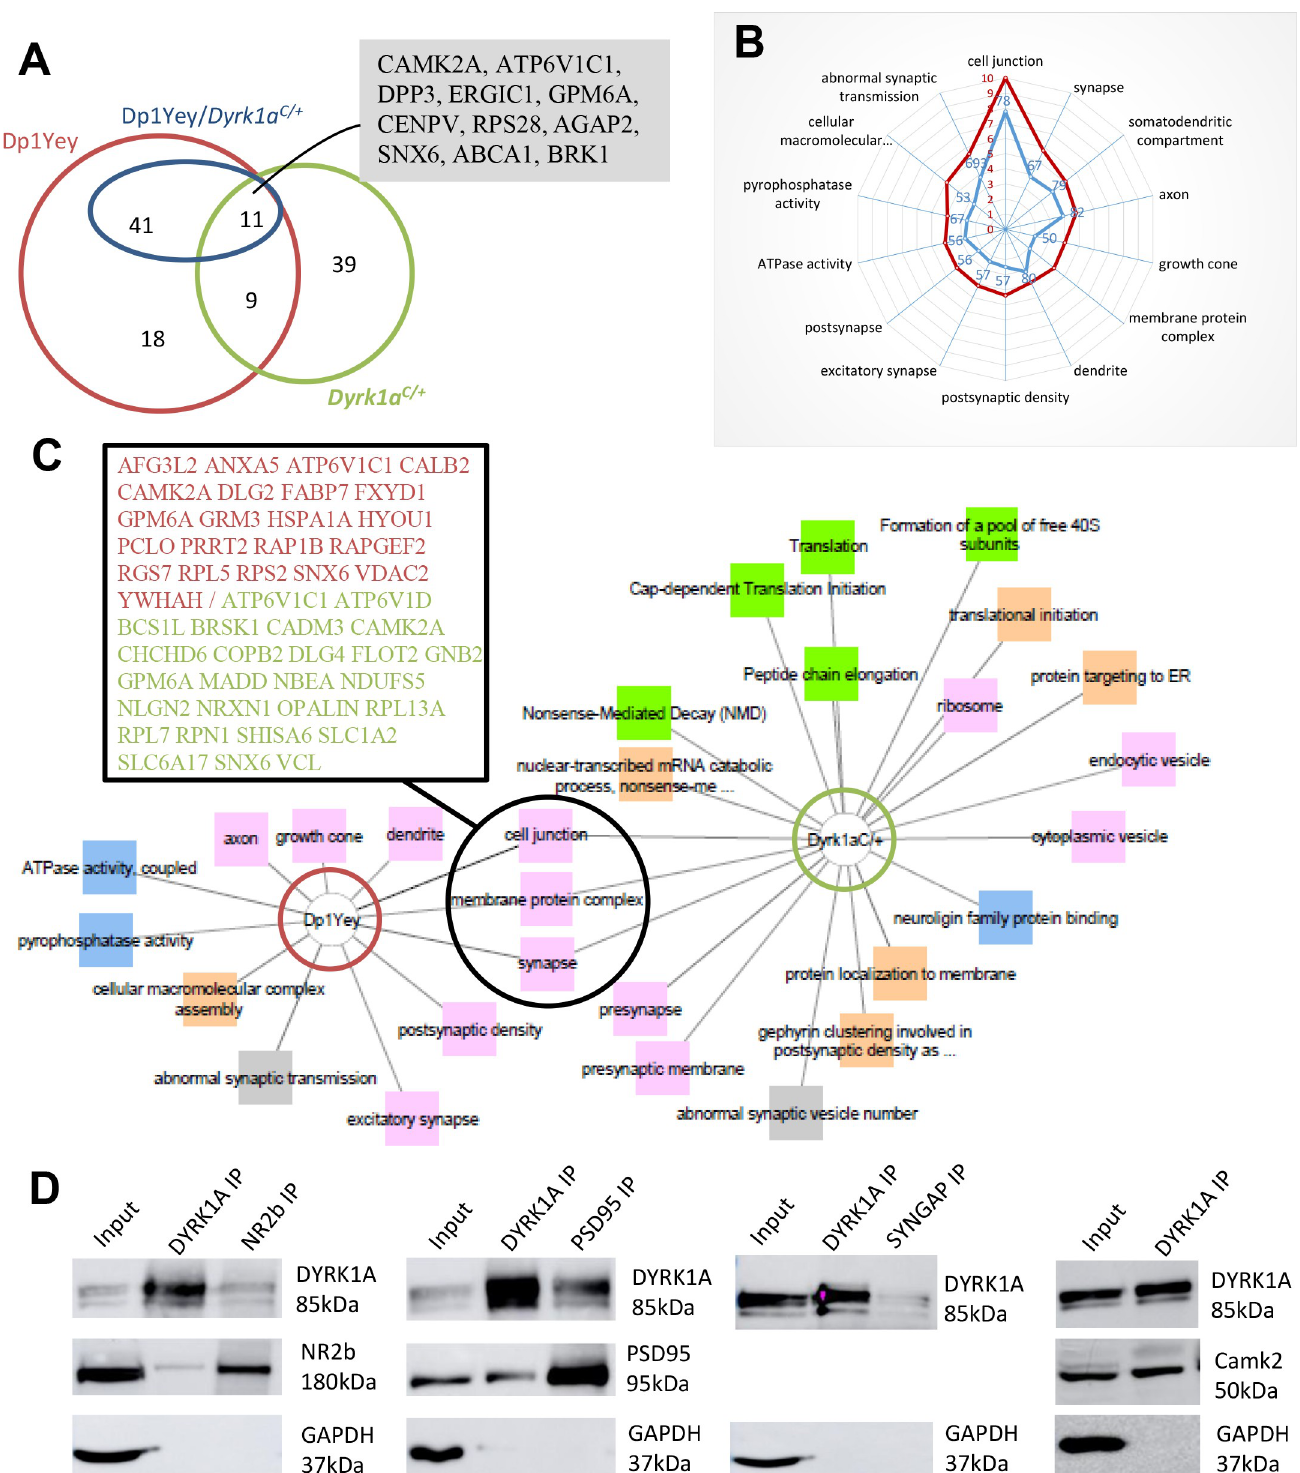
Fig 6. Proteomic analysis (A) Venn diagram showing the numbers of deregulated proteins in the different mouse models. The numbers of proteins shown for the Dp1Yey/ Dyrk1a C/+ model (in dark blue) correspond to proteins that were deregulated in the Dp1Yey and back to normal levels in this model (proteins that are regulated by Dyrk1a in the trisomy). Proteins deregulated by both Dyrk1a up and down-regulation (common to Dp1Yey, Dp1Yey/ Dyrk1a C/+ and Dyrk1a C/+ ) are listed in the grey shaded box. (B) Radar plots of GO terms that are mostly enriched in the Dp1Yey model (in red with scale bar corresponding to the log of the p-